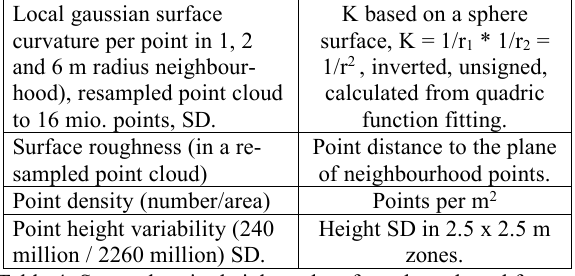
Table 4: Spectral, point height and surface shape-based feature descriptions of the Hainich forest area for reference tree Figure 5: “Huss”-area (defined in summer 1999 by J. Huss and species Smaltschinski – University of Freiburg) and individual tree crown reference information in the Hainich national park (status 2013). The main tree species (Bu/Es/BAh) (Nationalparkverwaltung Hainich, 2016. Exkursionsführer – Wissenschaft im Hainich, Hainich-Tagung 27-29.4.2016 Bad Langensalza, PDF download).